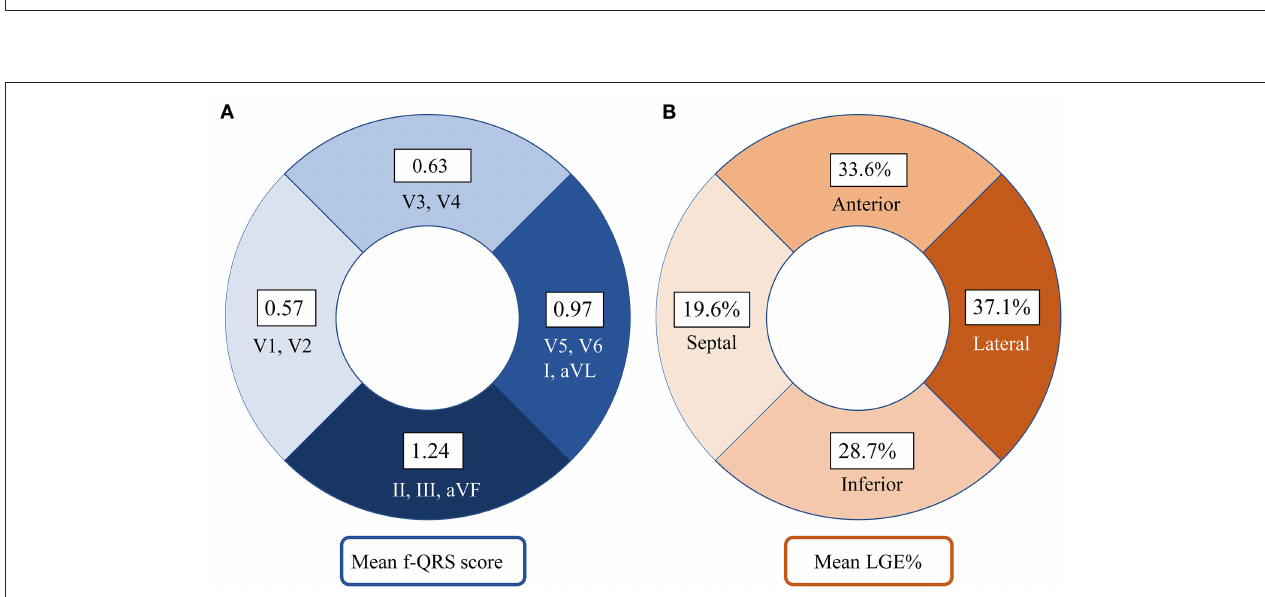
FIGURE 3 | Distribution of f-QRS score and LGE in the left ventricle in our Danon disease cohort. (A) The number on the fan-shaped block represents the mean f-QRS score of septal leads (V1–V2), anterior leads (V3–V4), lateral leads (I, aVL, V5, and V6), and inferior leads (II, III, and aVF). (B) The number on the fan-shaped block represents the mean LGE% of septal (S2, S3, S8, S9, and S14), anterior (S1, S7, and S13), lateral (S5, S6, S11, S12, and S16), and inferior (S4, S10, and S15) segments. LGE, late gadolinium enhancement; f-QRS, fragmented QRS.